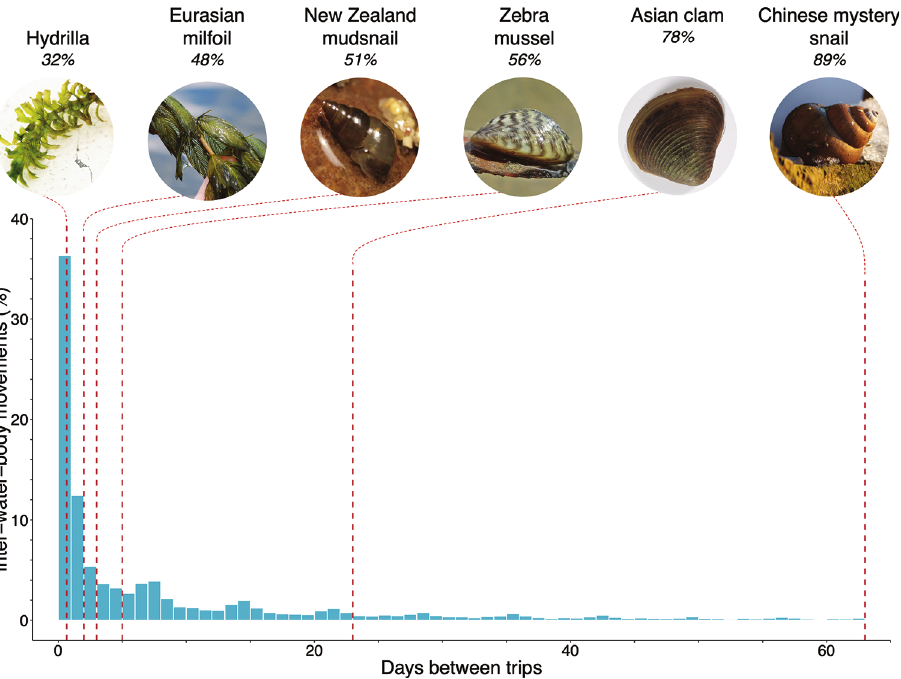
Figure 3. Percentage (%) of iBobber user movements between water-bodies according to the number of days between trips. Vertical lines represent published estimates of survival time when exposed to desic- cation in an overland vector for indicated invasive species (% of total movements stated). Photo credits: “Bay grasses on the Susquehanna Flats in Harford County, Md.” by chesbayprogram is licensed under CC BY-NC 2.0, “Eurasian Watermilfoil, Susquehanna Flats” by chesbayprogram is licensed under CC BY- NC 2.0, Potamopyrgus antipodarum” by fturmog is licensed under CC BY-NC-SA 2.0, “File:Dreissena polymorpha (Zebra mussel), Arnhem, the Netherlands.jpg” by Bj.schoenmakers is licensed under CC0 1.0, “File:Muschel Aller 7987.jpg” by NobbiP is licensed under CC BY-SA 3.0, “Chinese Mystery Snails in winter” by brentsview is licensed under CC BY-NC